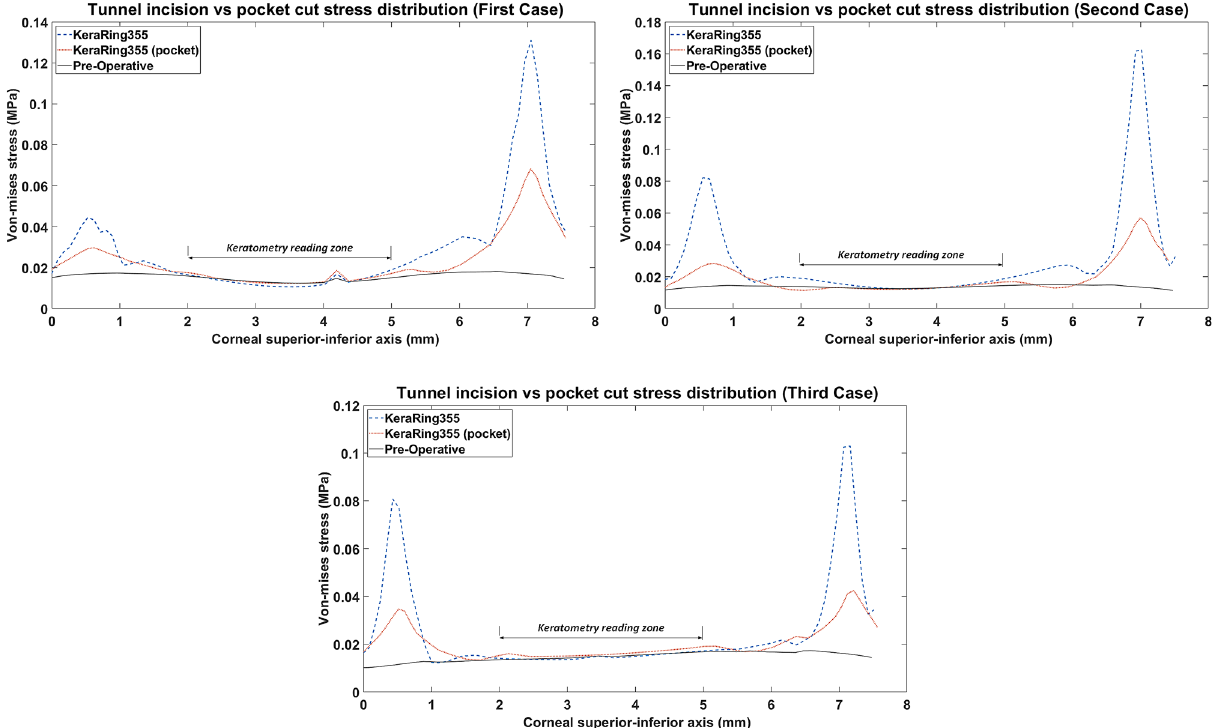
Figure 4. 2D comparison plot of Von Mises stress distribution in superior-inferior direction on the anterior corneal surface for all case scenario. (Kera355 implemented by tunnel incision and pocket incision are shown in the figure by light blue (dashed-line) and red (dotted-line)